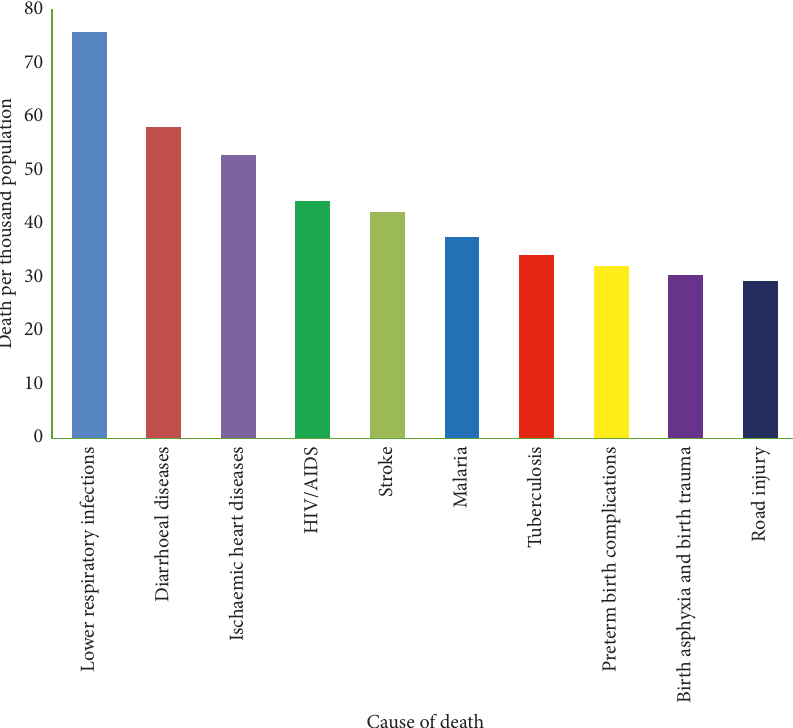
Figure 4: 2019 top ten leading causes of death in low-income countries [8].